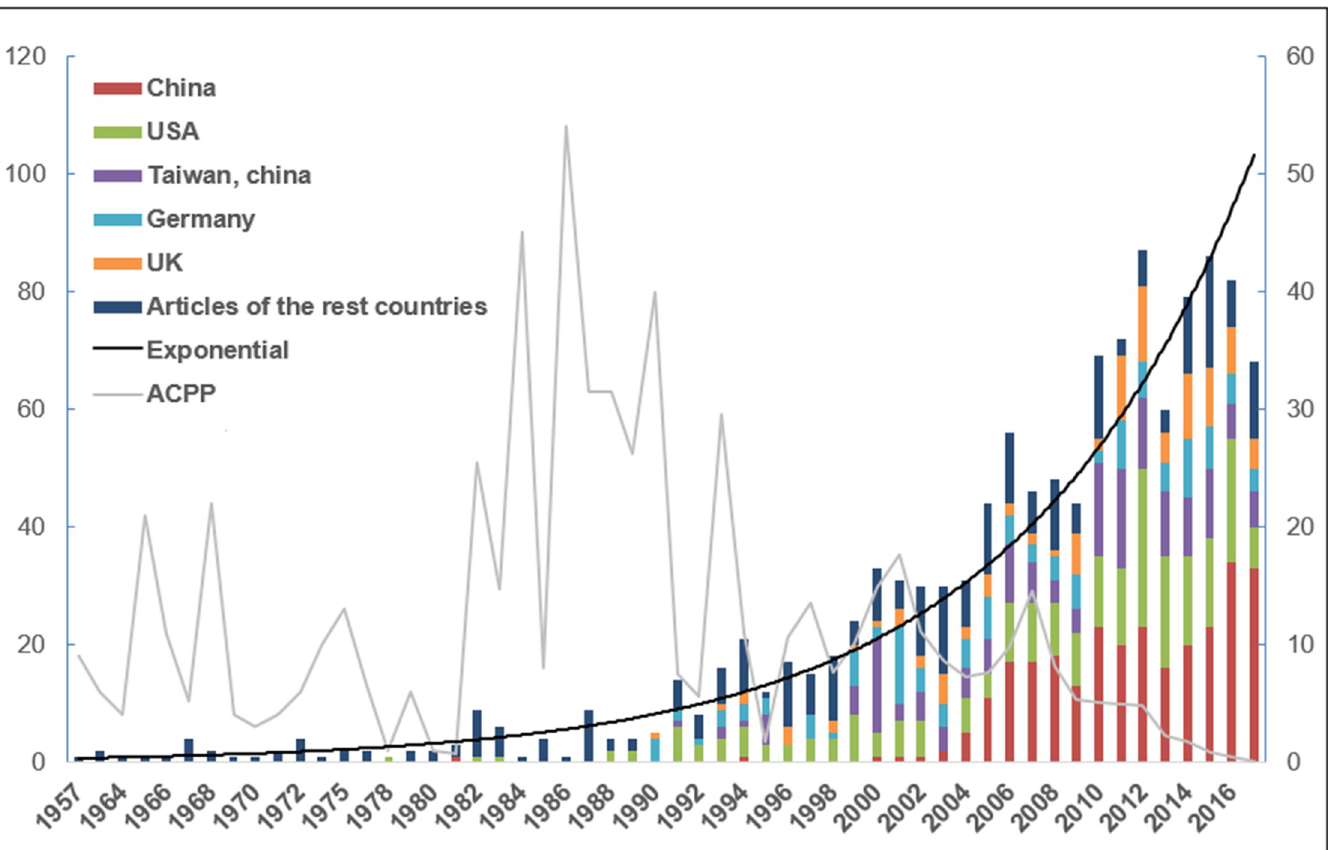
Fig 2. Worldwide output from 1957 to 2017. The left axis represents the total number of articles per year and the right axis represents the average citation per article per year (ACPP). https://doi.org/10.1371/journal.pone.0216135.g002 PLOS ONE | https://doi.org/10.1371/journal.pone.0216135 May 2,